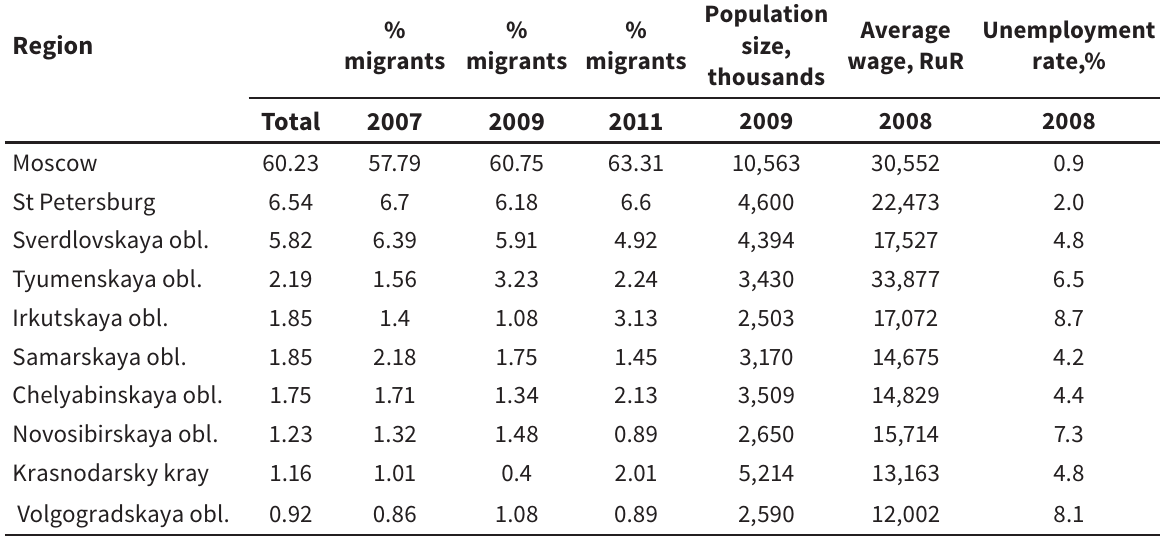
Top migrant destinations and selected destination characteristics